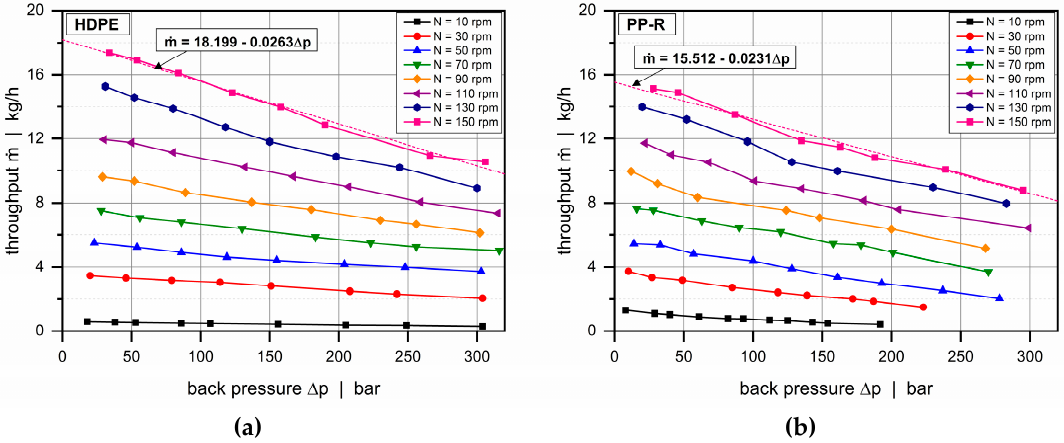
Figure 7. Screw characteristic curves for HPDE ( a ) and PP-R ( b ). A linear function was applied to describe the throughput–back pressure relationship for a screw speed of 150 rpm (mathematically).